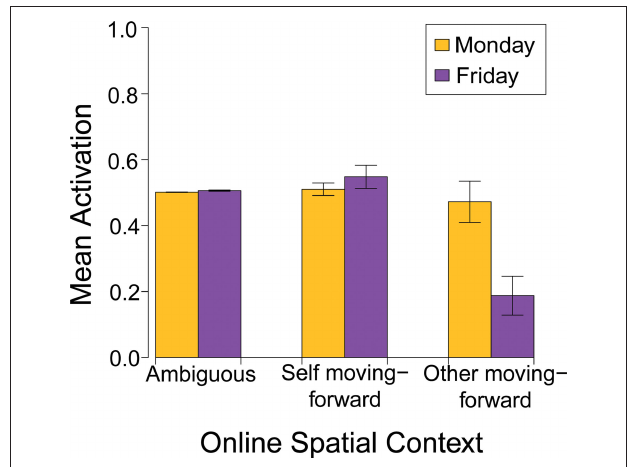
Figure 3 | The results of Simulation 1 showing that activating a particular spatial frame of reference biases the network’s predictions about movement in the temporal